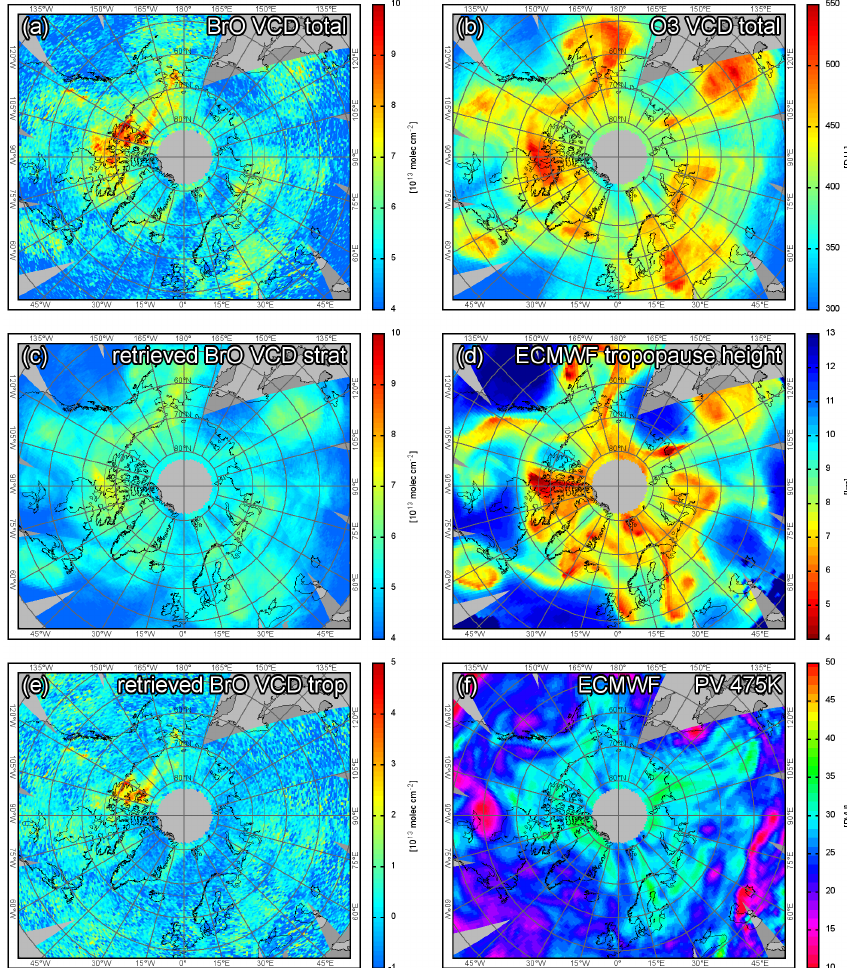
Fig. 1. Illustration of the decomposition of the total BrO VCD measured by GOME-2 into stratospheric and tropospheric contribution for 25 March 2009. The top row shows VCDs of BrO (a) and O 3 (b) assuming a geometric AMF. Coinciding spatial structures of enhanced VCDs are visible e.g. over Eastern Europe and Northern Siberia, which are attributed to stratospheric dynamics and variations of the tropopause height (d) . The BrO SCDstrat (c) is retrieved from measurements of BrO, O 3 , and NO 2 alone. The BrO VCDtrop (e) is the difference between (a) and (c) . The PV at the 475K isentrope (f) may be used to identify regions within the polar vortex (see Sect. 2.2.2). All VCDs are calculated using a geometric AMF; gray areas contain no